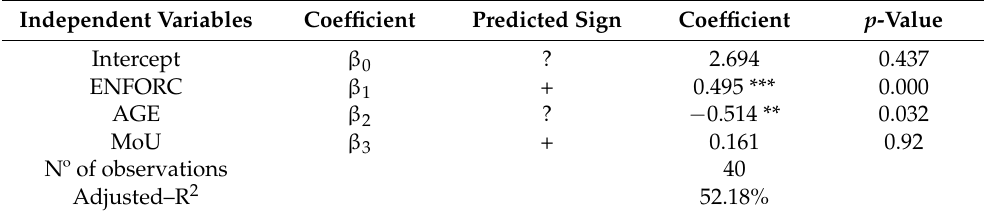
Table 3. Association between the number of enforcements and the complexity of an accounting standard. Independent